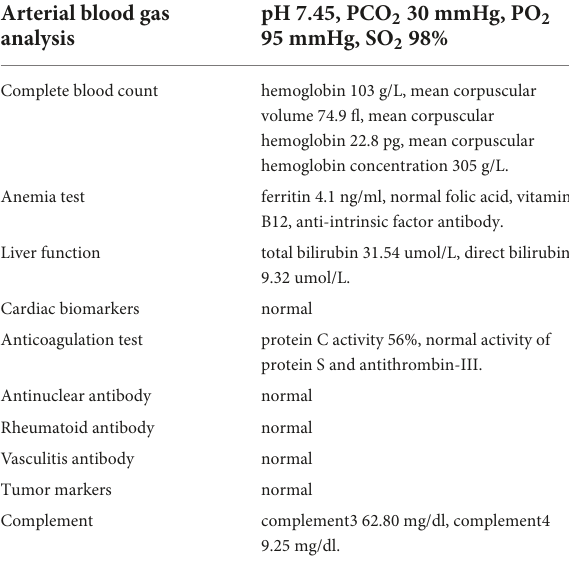
consistent with the results of pulmonary artery